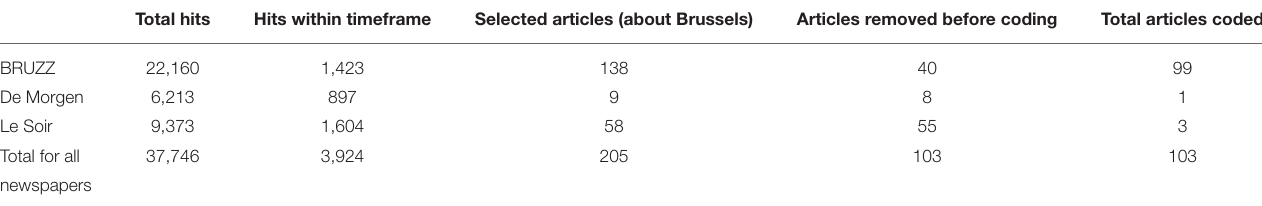
TABLE 1 | The results of the keyword